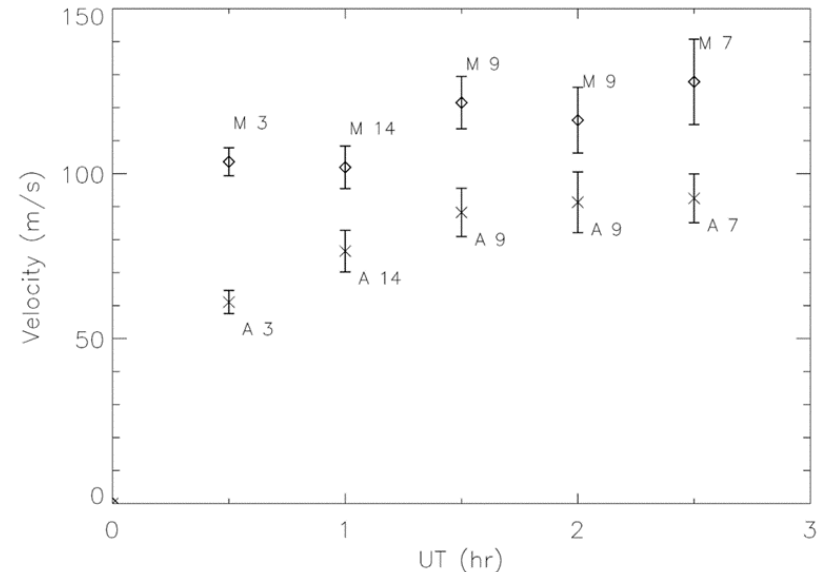
Figure 9. Zonal velocities from conjugate locations at Arecibo and Mercedes. Each individual data point is computed by averaging the values at different latitudes and binning the data in 30 min intervals. Mercedes values are shown with diamond symbols and Arecibo values with crosses. Each value has a number indicating how many points were used to compute it. Error bars represent the standard deviation of the mean.